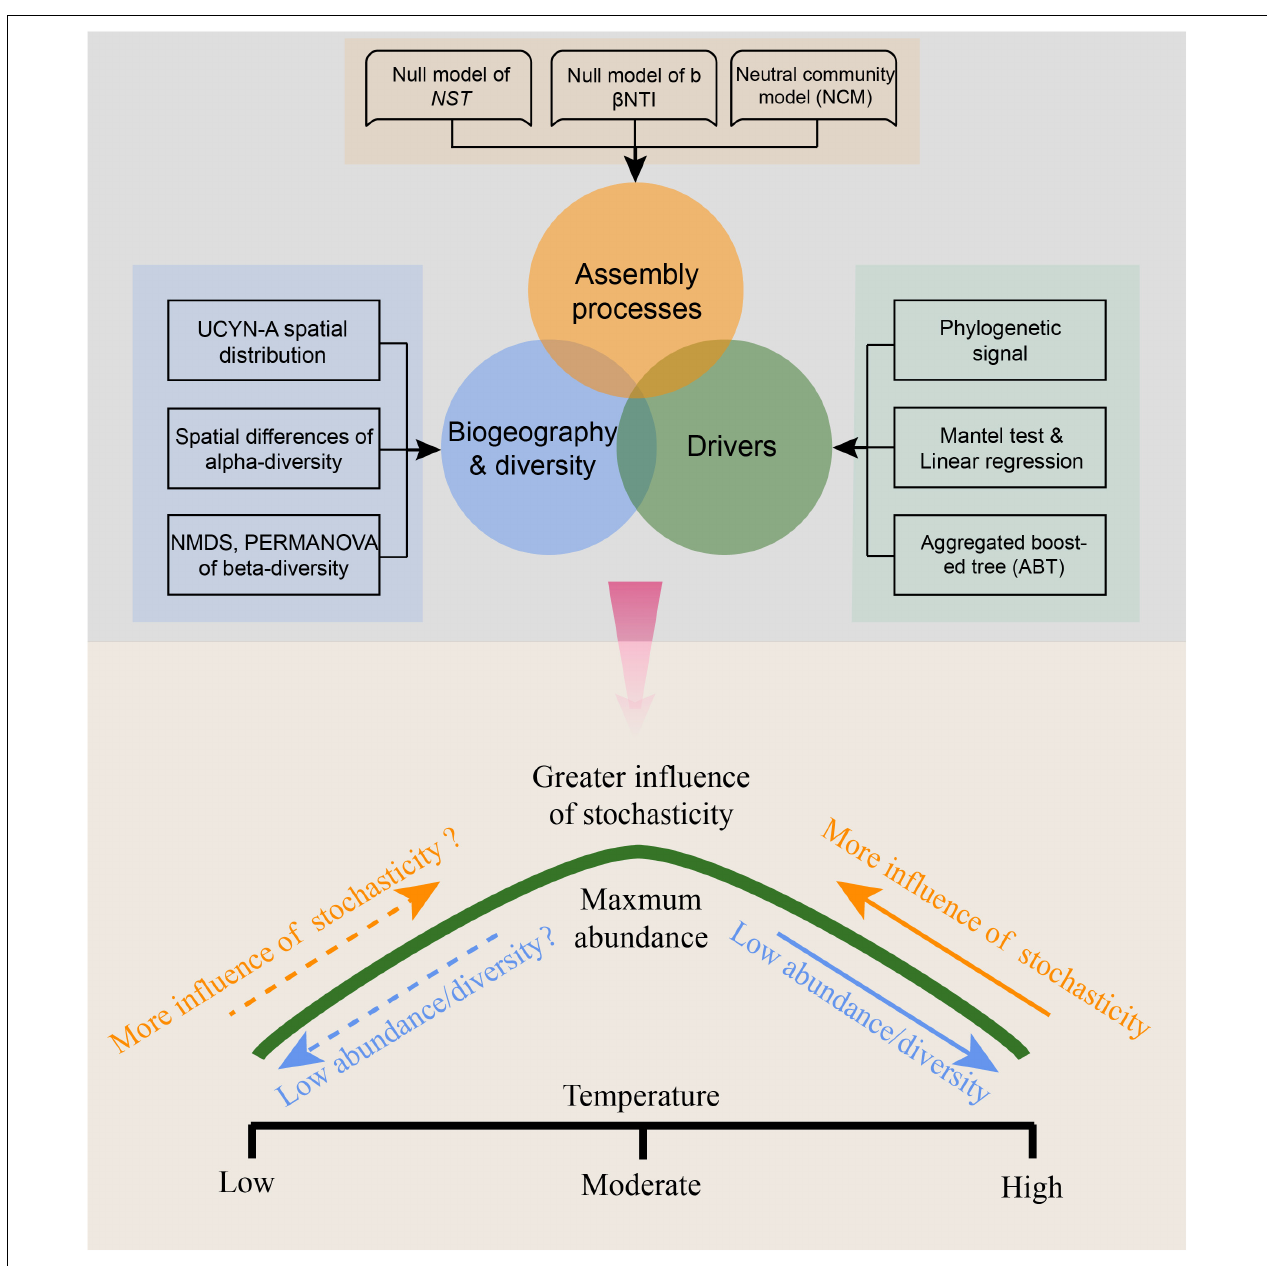
FIGURE 9 | Conceptual model showing the variation of stochasticity and abundance/diversity of UCYN-A communities with changing temperature. The dotted line means this part of the model has not been confirmed and requires further